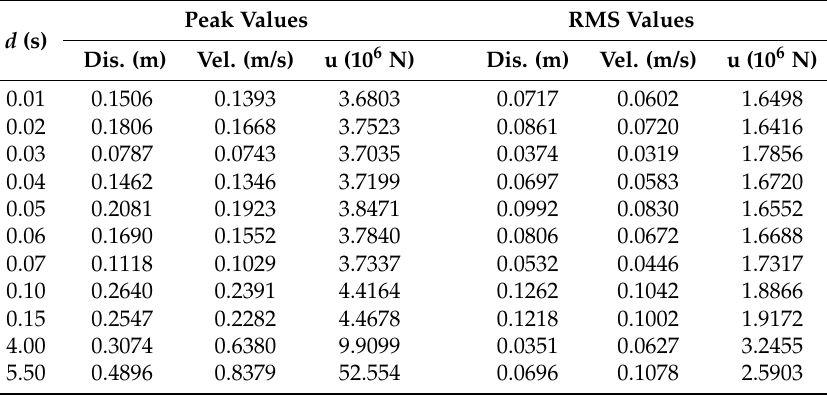
Table 3. Response peak and RMS values of structure and control force with MD-FOFCs.